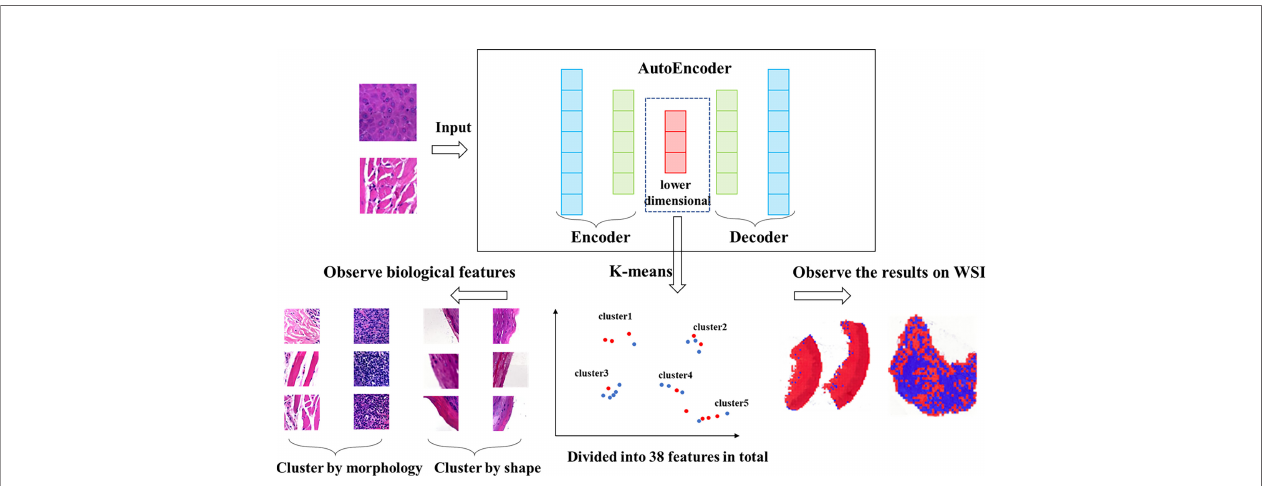
FIGURE 2 | Work fl ow of clustering. We clustered the data, which was encoded by autoencoder, obtained 38 features via K-means method. The higher the proportion of positive patches contained in feature, the greater the positive signi fi cance of the effect of immunosuppressive treatment. The higher the proportion of negative patches, the greater the negative signi fi cance of the treatment